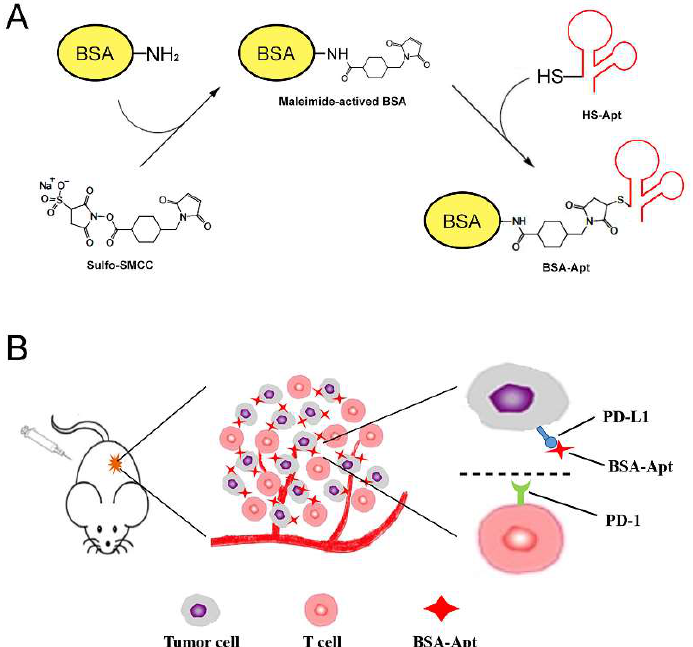
Figure 1. Schematic illustration of the BSA-Apt designed for colon cancer therapy. ( A ) Two-step reaction scheme for conjugating BSA with PD-L1 aptamer by a crosslinker (sulfo-SMCC). In this experiment, sulfo-SMCC first reacts with BSA to produce maleimide-activated protein. After removing non-reacted crosslinker, the maleimide-activated BSA reacts with the thiol-modified PD-L1 aptamers to form BSA-Apt. ( B ) PD-1/PD-L1 blockade scheme: BSA-Apt binds to PD-L1 expressed on the surface of tumor cells and blocks the PD-1/PD-L1 interaction.